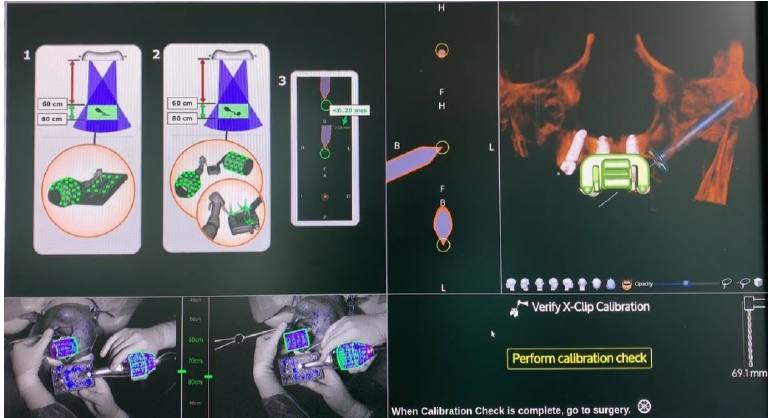
Figure 25. Spatial calibration of the drill immediately before the